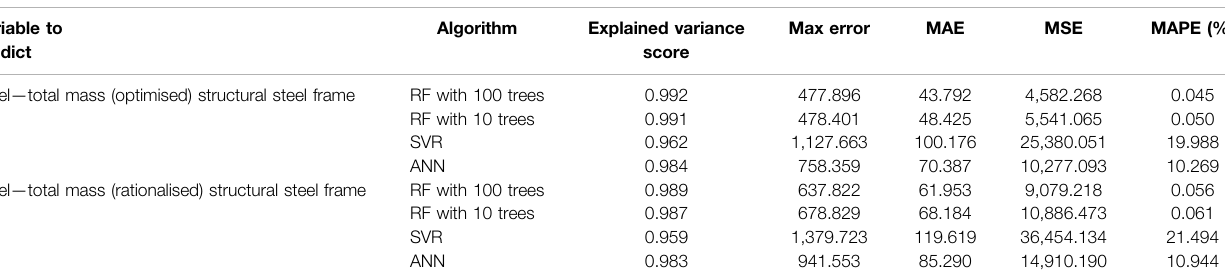
TABLE 2 | Average cross-validation error for results on steel. Variable to predict